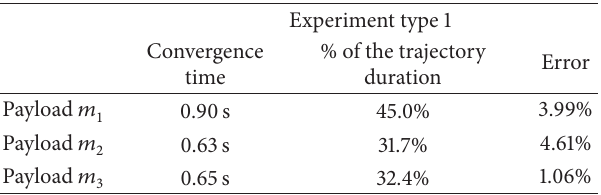
Table 3: Algebraic identifier resetting algorithm: evaluation for experiment type 1.